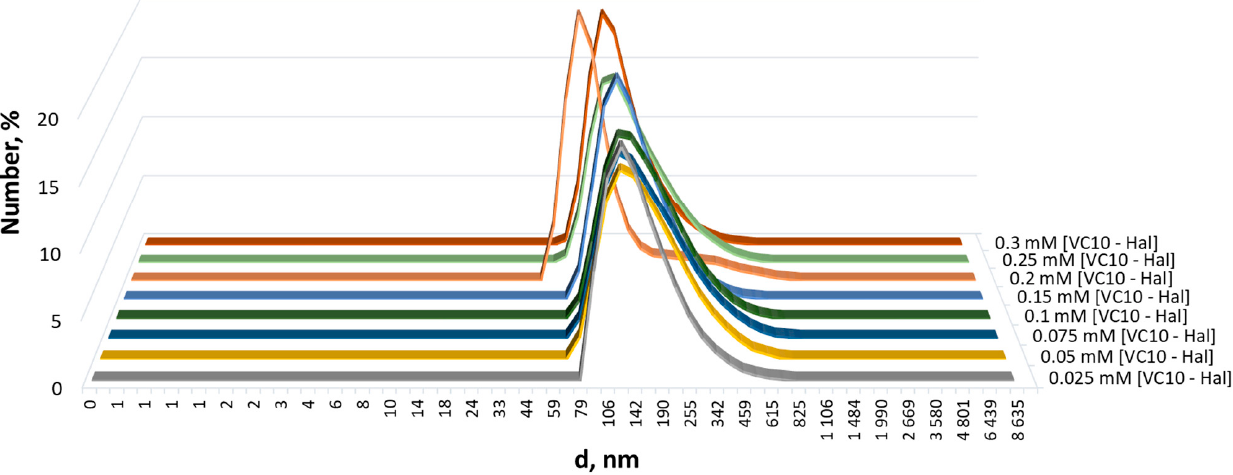
Figure 4. Particle size distribution by number in aqueous solutions of VC10–Hal (1:1) at different concentrations.